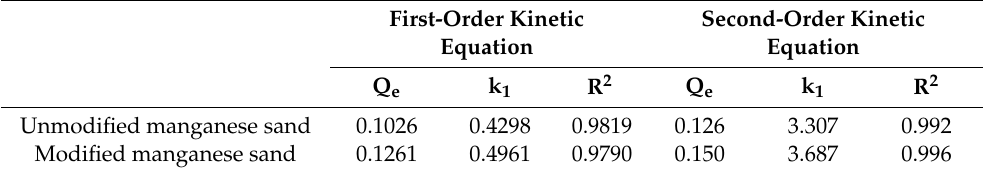
Table 6. Kinetic fitting parameters of the adsorption of manganese ions by manganese sand. First-Order Kinetic